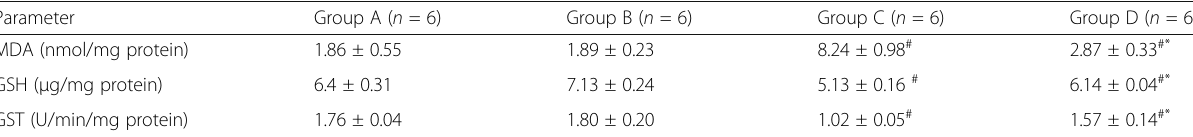
Table 3 Effect of H. clathratus on pulmonary oxidative stress and antioxidant defense system parameter (data expressed as mean ± SD)